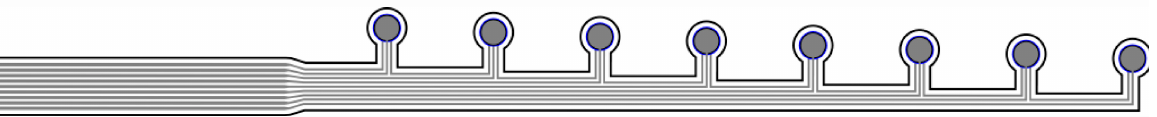
Figure 4. The prototype QTSS™ pressure sensor strip.